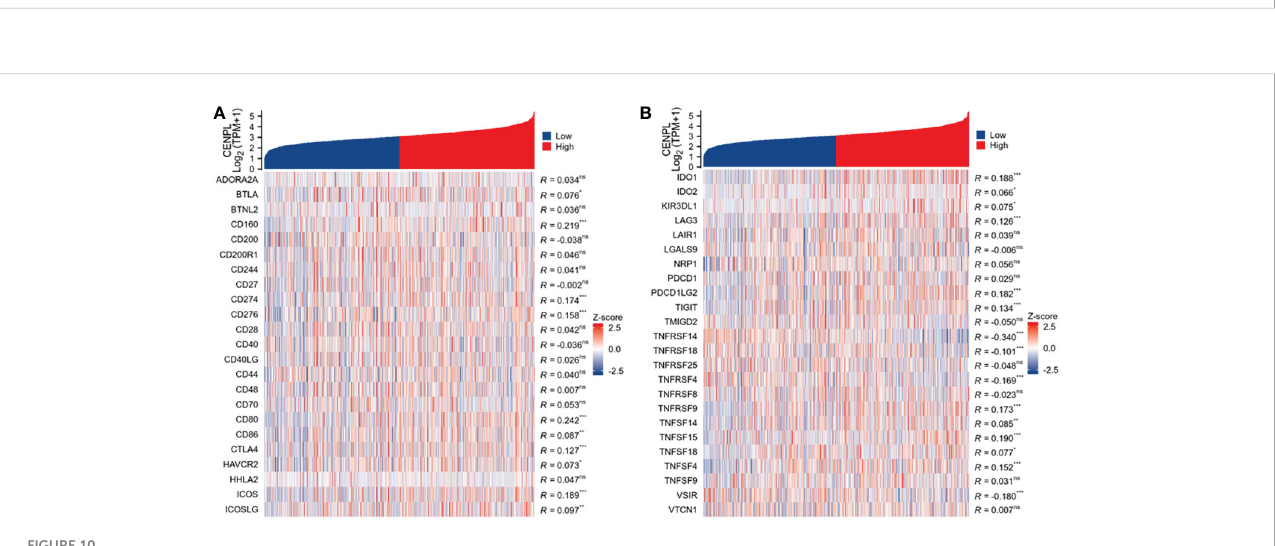
FIGURE 10 Co-expression of CENPL and immune checkpoint related